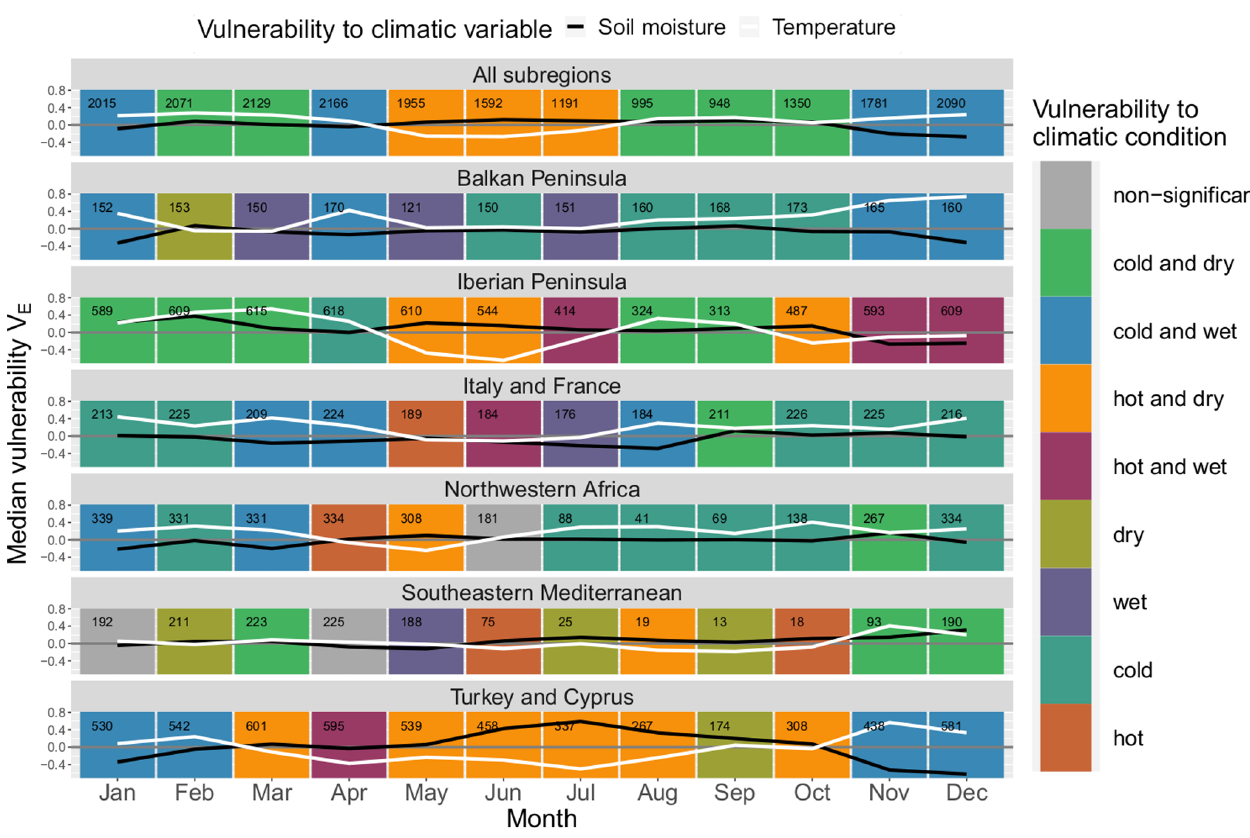
Figure A5. Median monthly ecosystem vulnerability per subregion. Vulnerability to temperature (ERA5-Land) is shown in white, and vulnerability to soil moisture (ERA5-Land at depth 7–28cm) is shown in black for each month of the year (columns) for each land cover (rows). Months with statistically significant deviation in climatic drivers during non-hazardous and hazardous ecosystem conditions according to the Mann–Whitney U test based on a significance level α = 0 . 05 are shown in colour (see legend); all other months are shown in grey. The number of grid points in which an event has occurred in this month and land cover within the period 1999–2019 is shown in the upper left corner of each